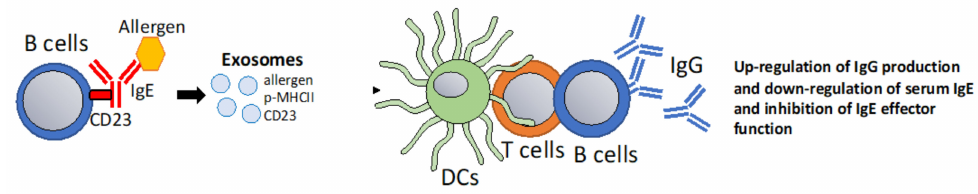
Figure 5. B cell-derived exosomes that modulate IgE-Facilitated Antigen Presentation. It has been proposed, that the low affinity IgE receptor CD23 can sort its ligands into exosomes [122]. Potentially, B cell mediated sorting of IgE-allergen complexes into exosomes via CD23 could be harnessed to promote T cell and IgG responses. Additionally, CD23 ligation in B cells has the effect of down- regulating IgE responses